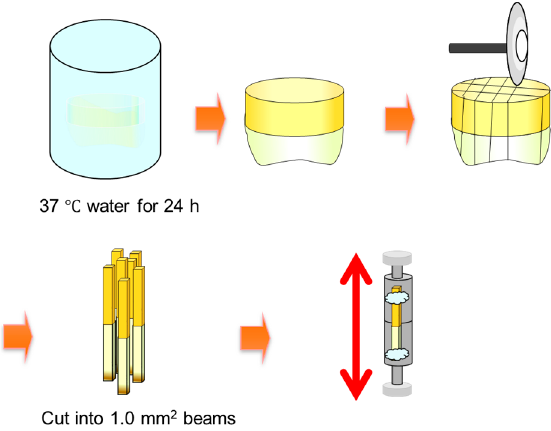
Figure 2. Procedure for microtensile bond strength testing.